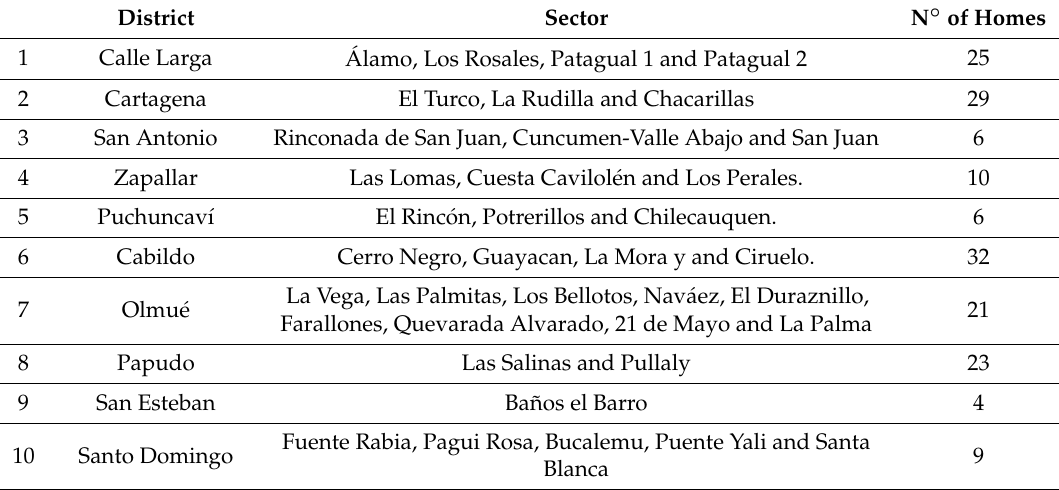
Figure 1. Location of the study area. Table 1. Rural sectors without access to the electricity grid as reported by the Energy Regional Ministry of Energy Secretariat (SEREMI) of the region of Valpara í so up to 4th January